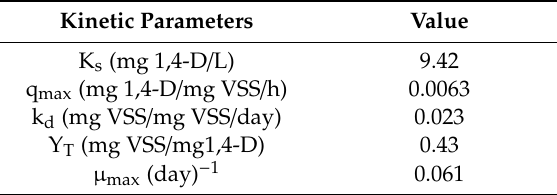
Table 3. Kinetic coefficients of 1,4-dioxane biodegradation.